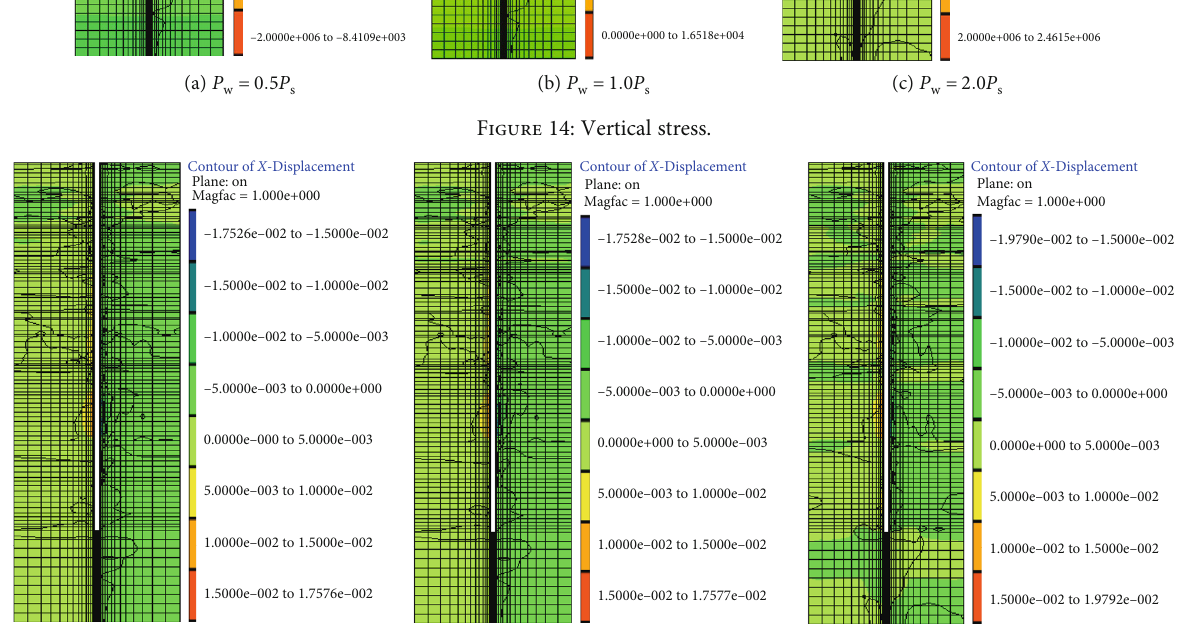
Figure 14: Vertical